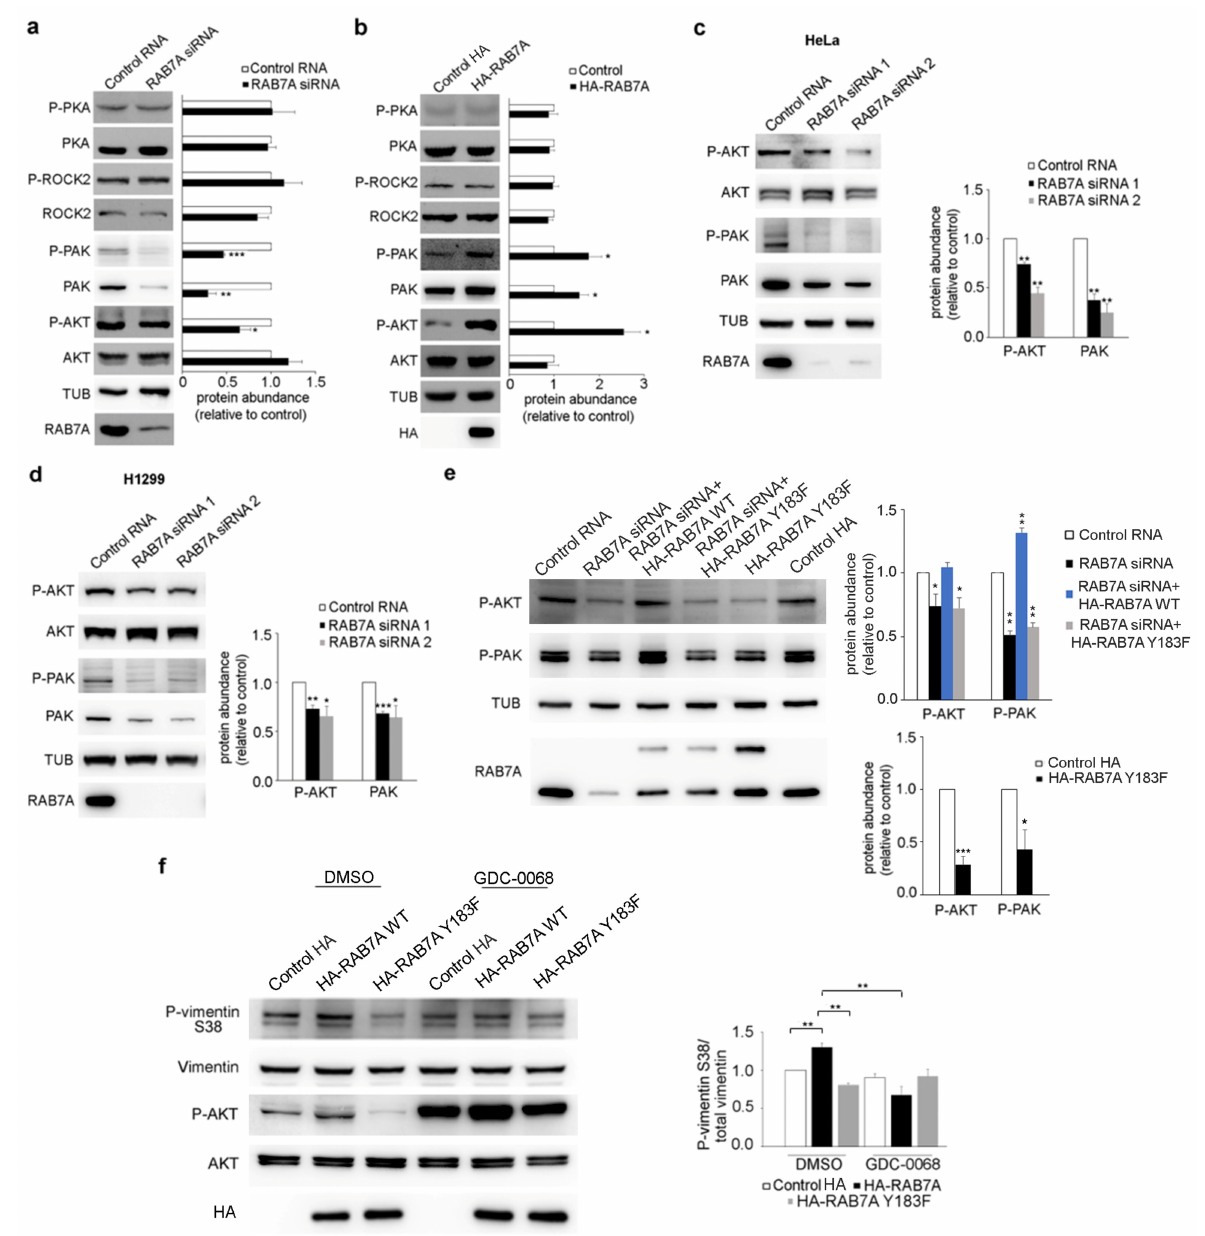
Figure 4. RAB7A regulates AKT kinase activity, PAK1 abundance, and vimentin phosphorylation. ( a ) HeLa cells were transfected with either control RNA or RAB7A siRNA and then lysed after 5 days or ( b ) transfected with plasmids encoding either HA or HA-RAB7A and lysed after 24 h. Lysates were subjected to Western blot analysis using the indicated antibodies. ( c ) HeLa or ( d ) H1299 cells were treated with control RNA or with RAB7A siRNAs and lysed after 5 days. Lysates were subjected to Western blot analysis using the indicated antibodies. Quantifications of total PAK kinase and phosphorylated AKT kinase are shown. ( e ) HeLa cells were treated with control RNA or with RAB7A siRNA or transfected with plasmids coding for HA or HA-RAB7A Y183F . RAB7A-silenced cells were also transfected with plasmids encoding HA-RAB7A WT or Y183F to rescue RAB7A function. Lysates were subjected to Western blot analysis using the indicated antibodies. Quantification of phosphorylated AKT and PAK1 kinases was shown. ( f ) HeLa cells were transfected with plasmids encoding either HA, HA-RAB7A WT , or HA-RAB7A Y183F . 24 h after transfection cells were incubated with the AKT inhibitor GDC-0068 1 µ M or DMSO for 24 h and then lysed. Lysates were subjected to Western blot analysis using the indicated antibodies. Quantification of P-vimentin Ser38 is shown. All data represent the mean ± s.e.m. of at least three independent experiments. * = p < 0.05; ** = p < 0.01; *** = p <